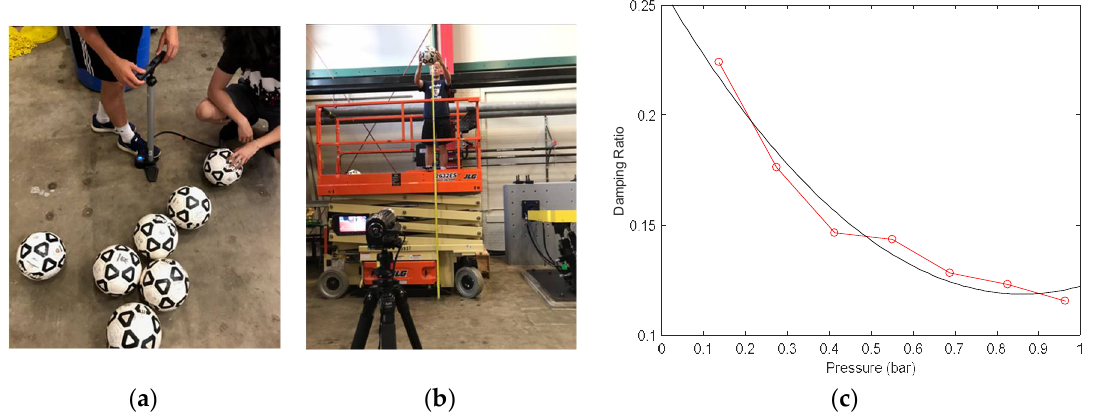
Figure 2. Photographs of ( a ) pumping balls to pressure; ( b ) video recording ball dropped at 3.084 m (10 ft) height; and ( c ) experimentally determined average damping ratio as a function of pressure (experimentally measured mean damping ratio—red circles; Equation (9)—black curve).